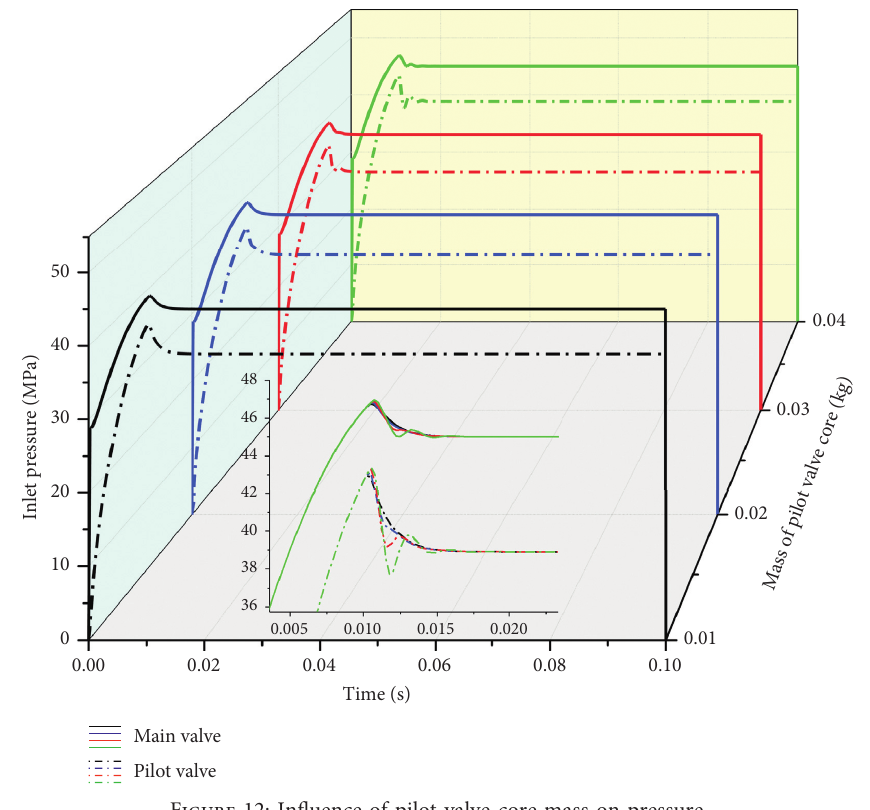
Figure 12: Influence of pilot valve-core mass on pressure.